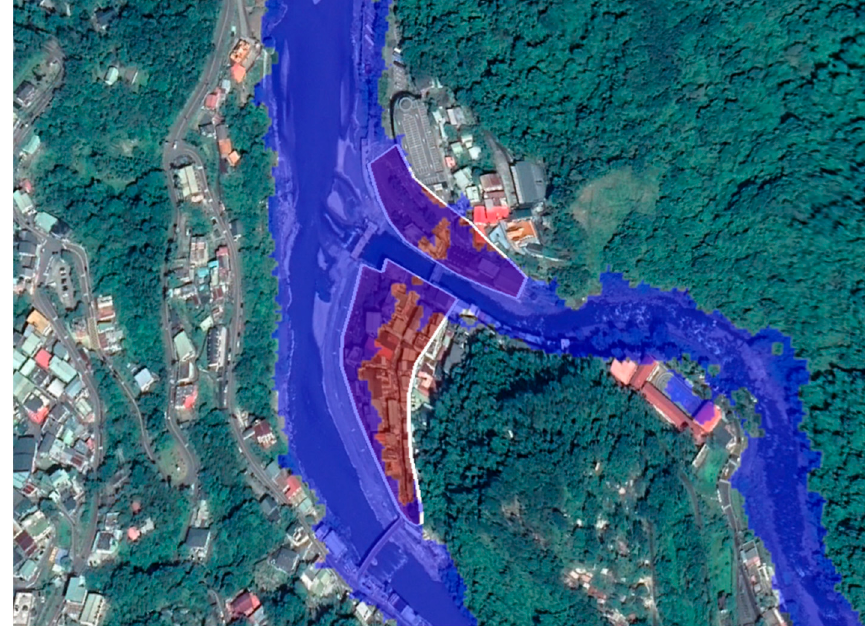
Figure 10. Comparison of the hindcast (blue coverage) and survey (inside the white lines) for the Typhoon Soudelor (2015)-induced flood extent at the junction of the Nanshi and Tonghou Rivers.